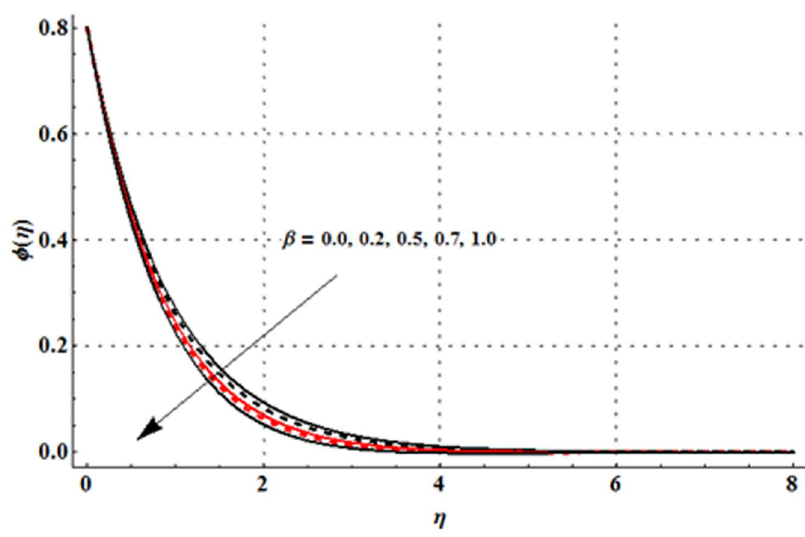
Figure 17. Influence of b on the concentration profile w ( g ) when M ~ 0 : 6, Rd ~ 0 : 4, l 1 ~ 0 : 5, l ~ 0 : 3 ~ N , Pr ~ 1 : 2, S ~ 0 : 2 ~ S (cid:2) and Sc ~ 1 : 0 :